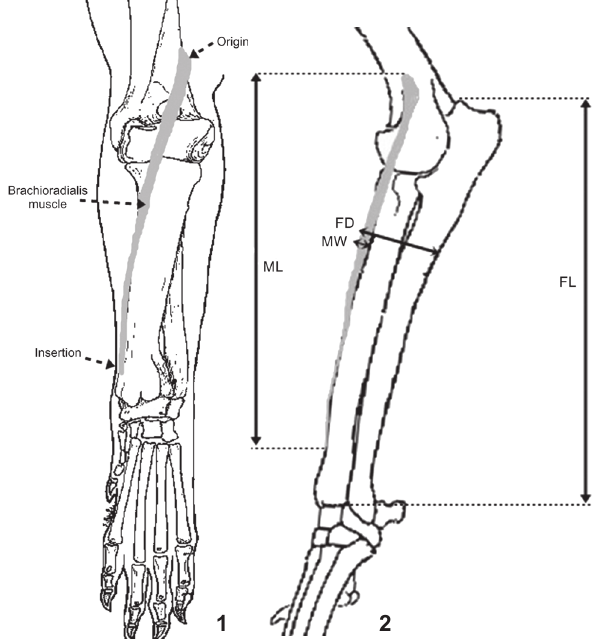
Figures 1-2. (1) Schematic representation of the basic arrangement of brachioradialis muscle in the domestic dog. (2) Schematic repre- sentations of the measurement points. ML: muscle length; FL: fore- arm length; MW: muscle width; FD: forearm